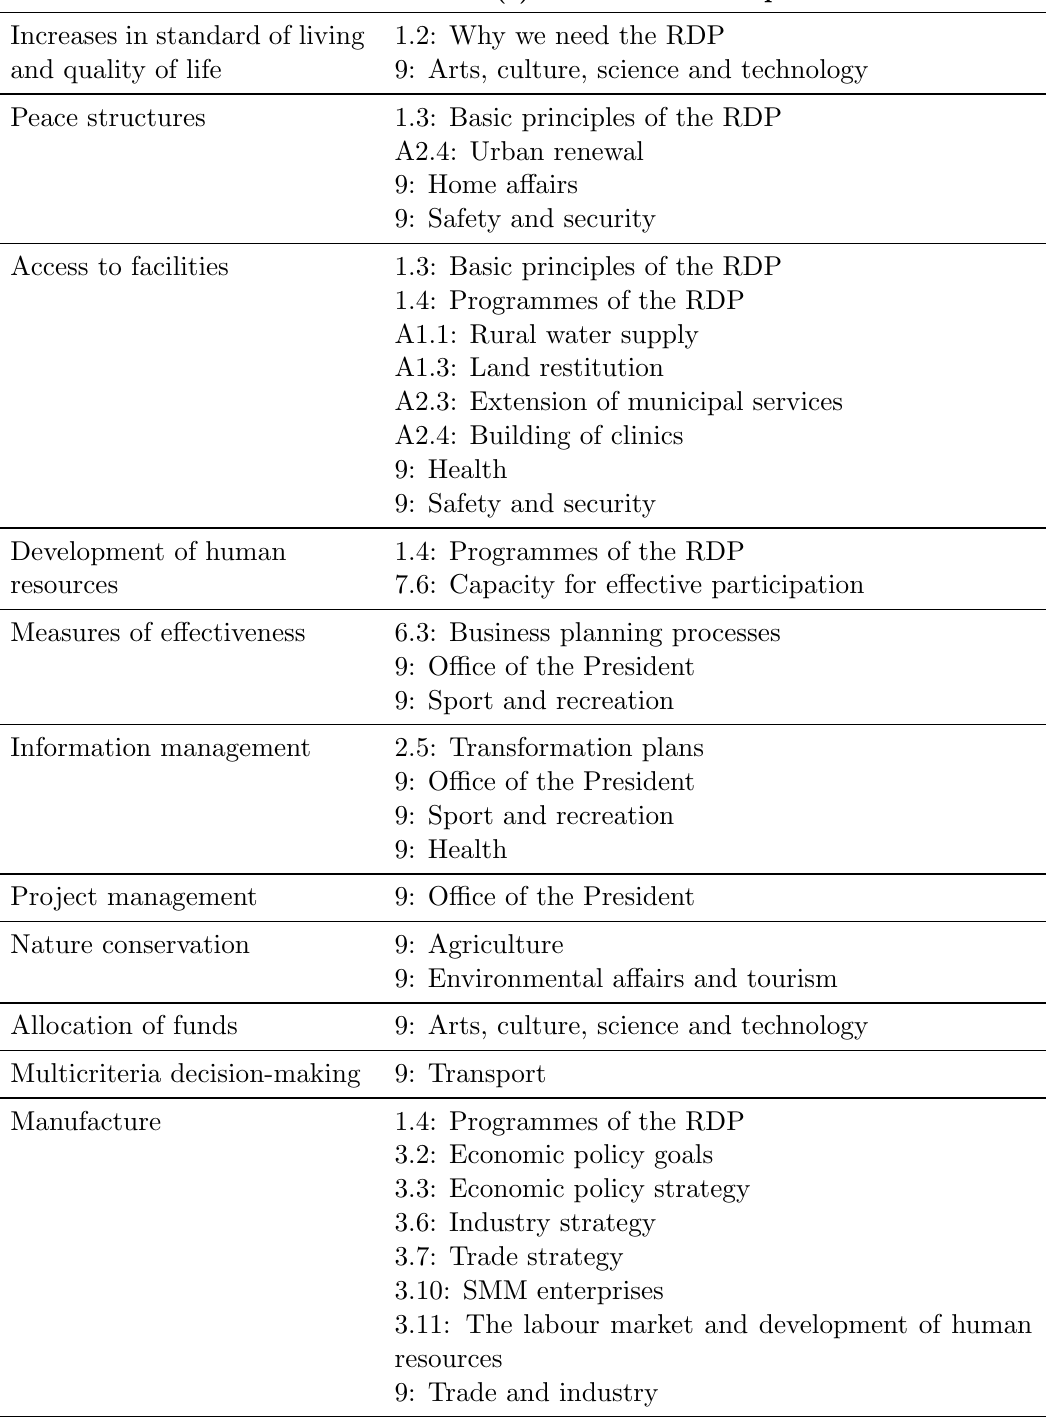
Table 1: Summary of White